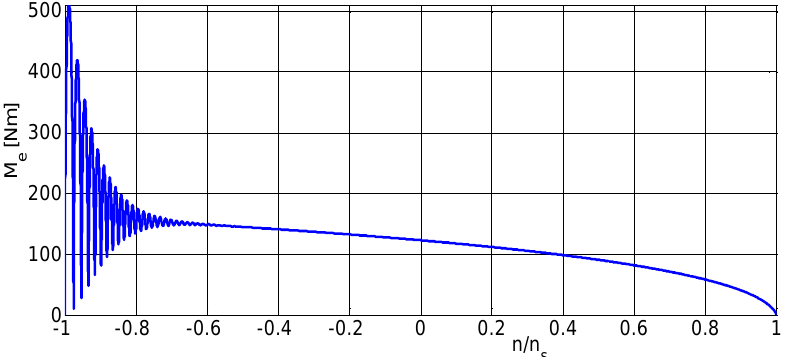
Figure 10. Torque – speed M e ( n ) trajectory of a solid-rotor induction motor during the start-up. On the other hand, Figure 11 shows the torque – speed trajectory M e ( n ) during the reversion of the motor for the load torque M m = 0 and the moment of inertia J = 20 J N .